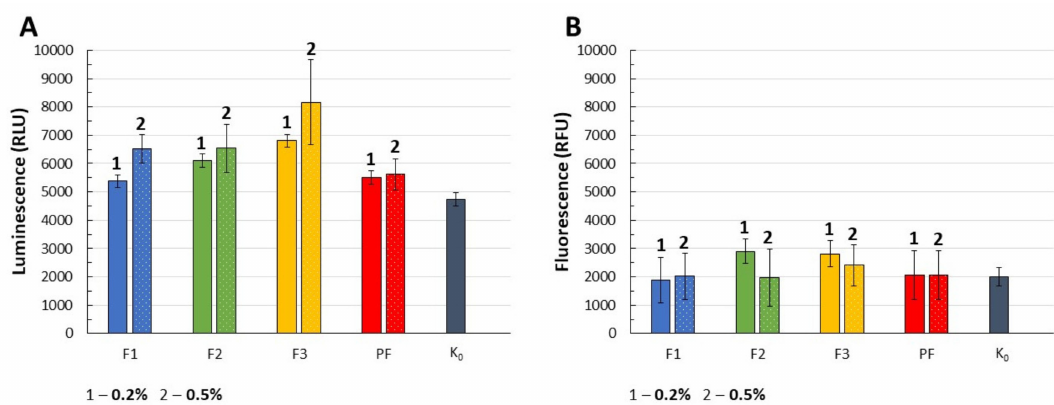
Figure 10. Intensity of luminescence signal as a sign of apoptosis ( A ) and fluorescence signal as a sign of necrosis ( B ) recorded for F1–F3 and placebo films (PF) at concentrations of 0.2% and 0.5% with reference to the negative control K 0 (untreated cells). For the positive control (50 mM H 2 O 2 ), luminescence was 964542.28 ± 32319.18 RLU and fluorescence– 35750.39 ± 2510.64 RFU (mean ± SD, n = 5, p <